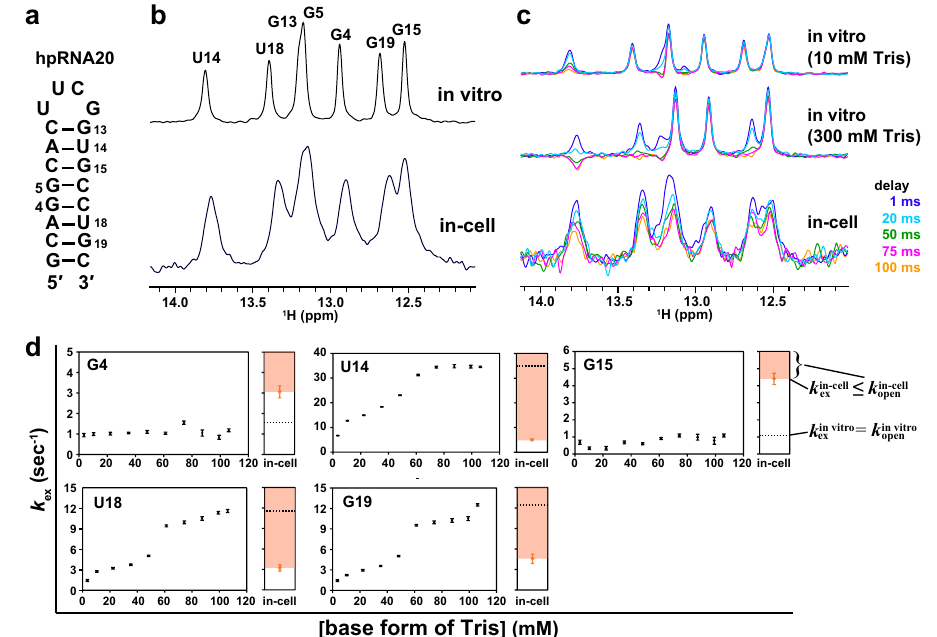
Fig. 2 | AnalysisoftheexchangeofiminoprotonsoftheRNA hairpin structure with the proton of solvent water. a Secondary structure of fully 2 ′ - O -methylated hpRNA20. b 1D 1 H-NMRspectraofhpRNA20recordedunderinvitro(upper)andin- cell (lower) conditions. c Water magnetization transfer experiments on hpRNA20 carried out under two in vitro conditions, 10mM (top) and 300mM Tris (middle), and under in-cell conditions for living HeLa cells (bottom). Spectra recorded with different delay times after water-selective inversion are superimposed. d The comparison of the deduced k open values of hpRNA20 between in-cell and in vitro conditions by using the k ex value as a reference. For each residue, the dashed line indicates the maximum k ex value for various concentrations of the base form of